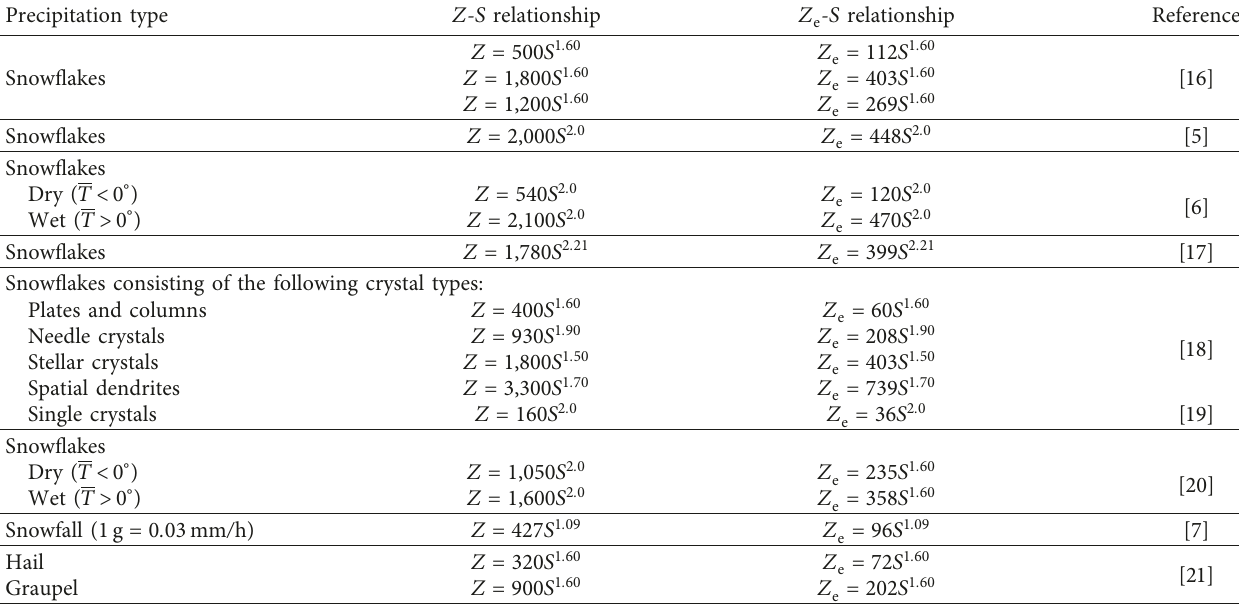
Table 2: Z - S relationships collected from past studies and reports.